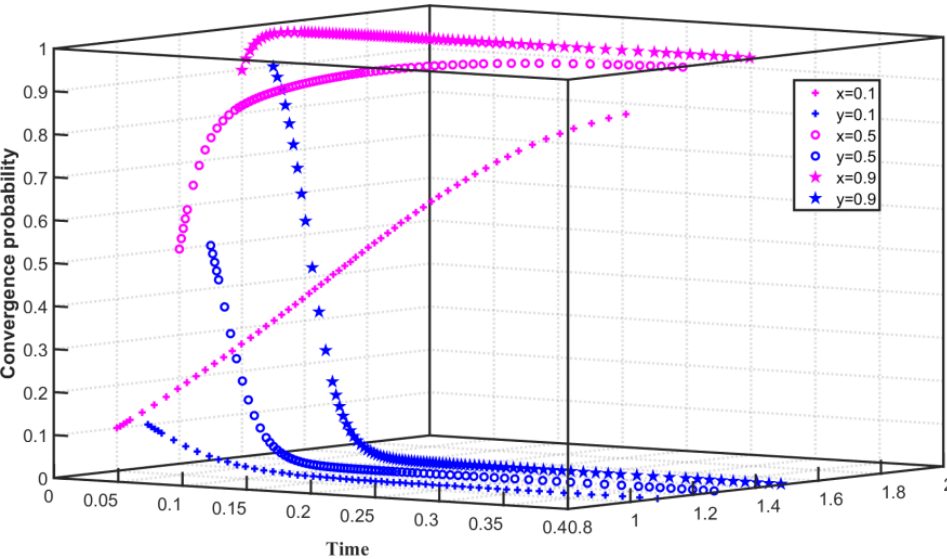
Figure 4. Evolution path of two-party game system under low emission reduction cost and high